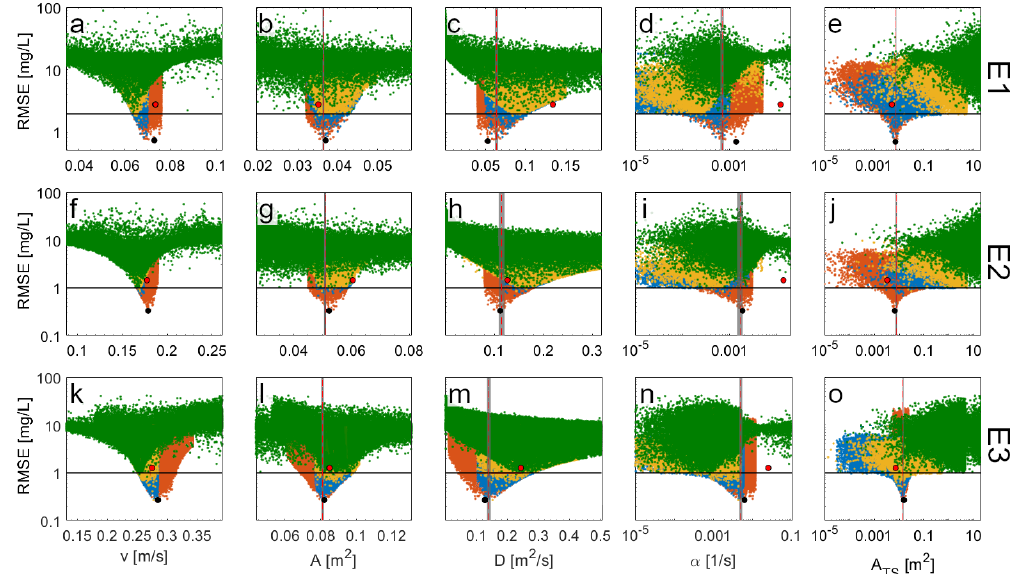
Figure 2. Parameter values plotted against the corresponding RMSE values for the TSM results conducted for the tracer injections (a–e) E1, (f–j) E2, and (k–o) E3. (a–j) Green, yellow, blue, and orange dots indicate results respectively for the first, second, third, and fourth TSM iterations. (k–o) Green dots indicate results for the first and second TSM iterations, while yellow, blue, and orange dots indicate results respectively for the third, fourth, and fifth TSM iterations. Each TSM iteration was conducted via 115000 parameter sets. The red dots indicate OTIS-MCAT results (the best parameter set after the first TSM iteration for v equals v peak ), while the black dots indicate the best- performing parameter value after the used iterative TSM approach. The horizontal black line indicates the RMSE ADE (Table 2). The vertical dashed red line indicates OTIS-P results, while the 95% confidence range for OTIS-P results is indicated via vertical grey